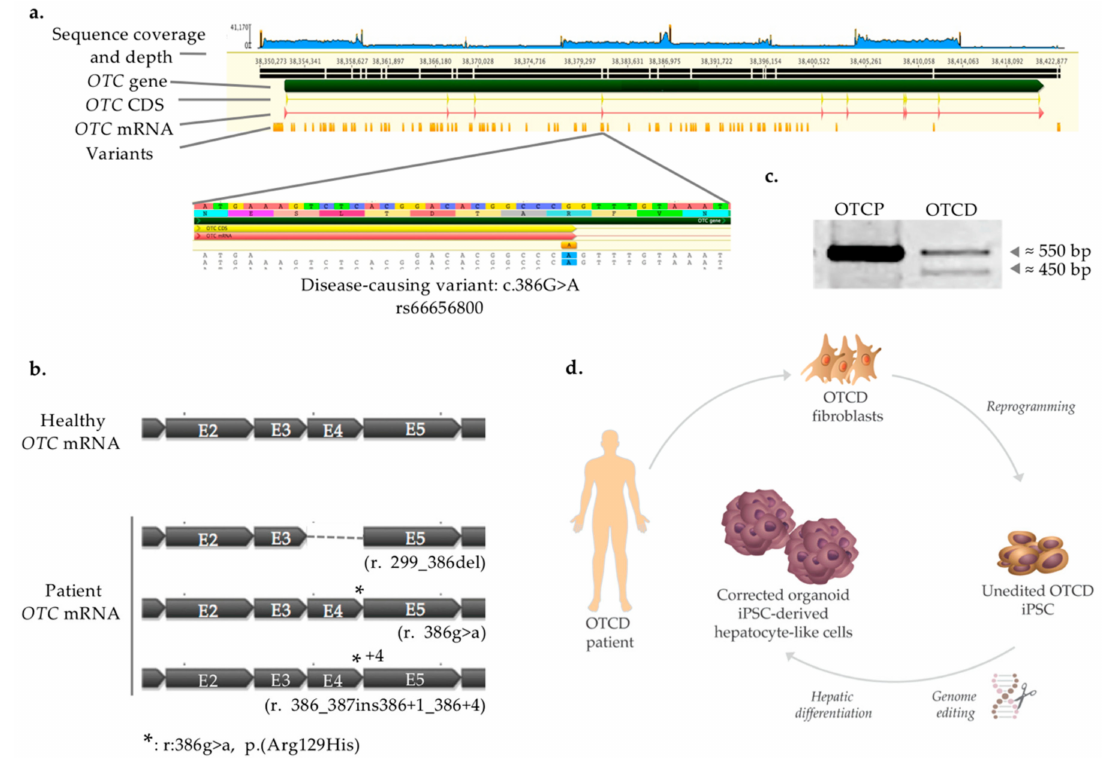
Figure 1. Mutation identification and study overview. ( a ) OTC gene sequence alignment in OTC-deficient (OTCD) patient to reference gene. Sequencing coverage and depth, OTC gene, coding sequence (CDS), mRNA and variants identified after alignment of OTC gene in OTCD patient to reference gene (NCBI ID: 5009) are shown. The genomic region containing the single nucleotide polymorphism (SNP, rs66656800) causing the disease is presented in the bottom panel (c.386G>A). ( b ) Representation of OTC transcript in healthy (OTC-proficient, OTCP) hepatocytes and OTCD patient. Three different OTC transcripts are present in patient’s hepatocytes: skipping of exon 4 (r.299_386del), elongation of exon 4 with the first 4 bp of intron 4 (r.386_387ins386+1_386+4) and the full length of transcript with exon 4 harboring the mutation (r. 386g>a). Grey boxes represent introns (E2, E3, E4, E5). *: Mutation r.386g>a on RNA level which results in